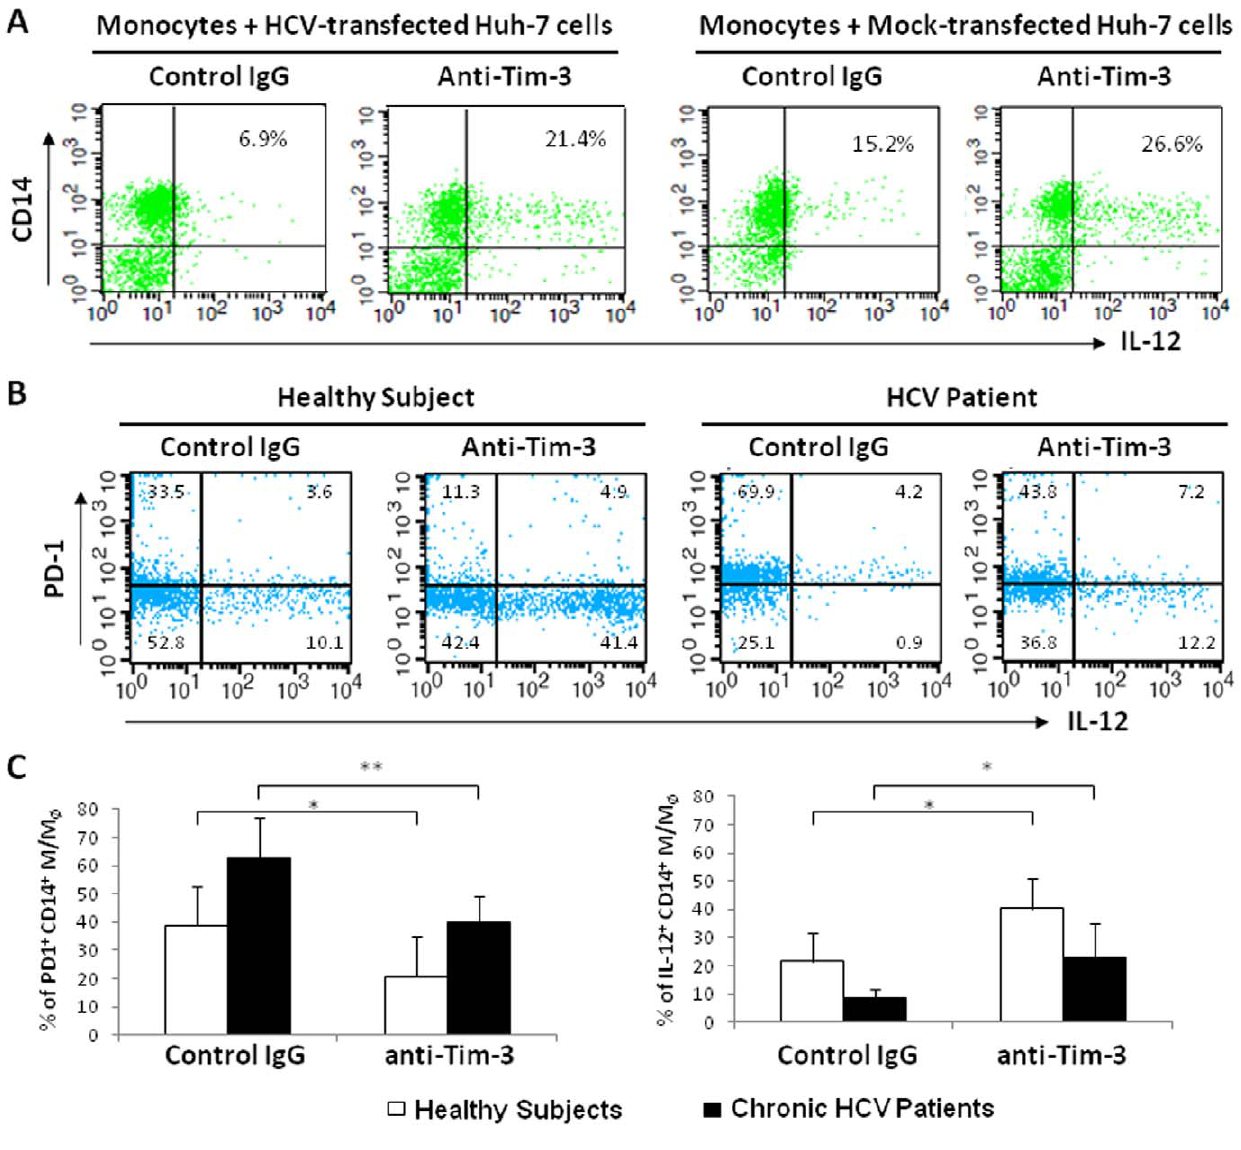
Figure 6. Tim-3 blockade significantly improves IL-12 production and reduces PD-1 expression on CD14 + M/M Ø . A) Purified M/M Ø was incubated with Huh-7 cells in a ratio of 10:1 at 48 h after HCV or mock transfection. Anti-Tim-3 or control IgG was added into the co-culture system at the same time and incubated overnight, followed by stimulation with LPS/R848 for another 18 h. IL-12 expression in CD14 + M/M Ø was detected by flow cytometry. B) Representative flow cytometric dot plots from one healthy subject and one HCV-infected individual showing the effect of Tim-3 blocking on PD-1 and IL-12 expressions in CD14 + M/M Ø . Gating strategy for identifying CD14 + M/M Ø subsets is the same as in Fig. 4A. C) PBMC from healthy subjects (n=6) and chronically HCV-infected individuals (n=6) were pre-incubated with anti-Tim-3 or control IgG antibodies 48 h, followed by stimulation with LPS/R848 for 18 h. PD-1 and IL-12 expressions were detected by flow cytometry. The percentages of PD-1 + CD14 + M/M Ø or IL-12 + CD14 + M/M Ø of healthy subjects as well as chronically HCV-infected individuals are shown. The p value (* , 0.05, ** , 0.01) was denoted above the group of study